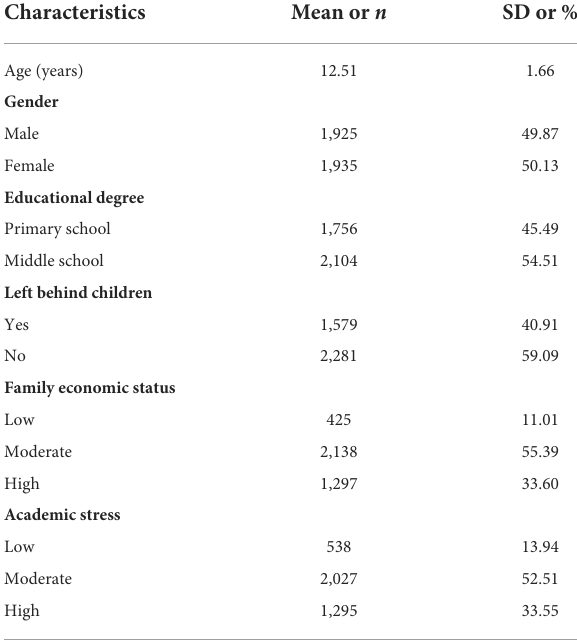
TABLE 1 Sociodemographic characteristics of participants ( n =